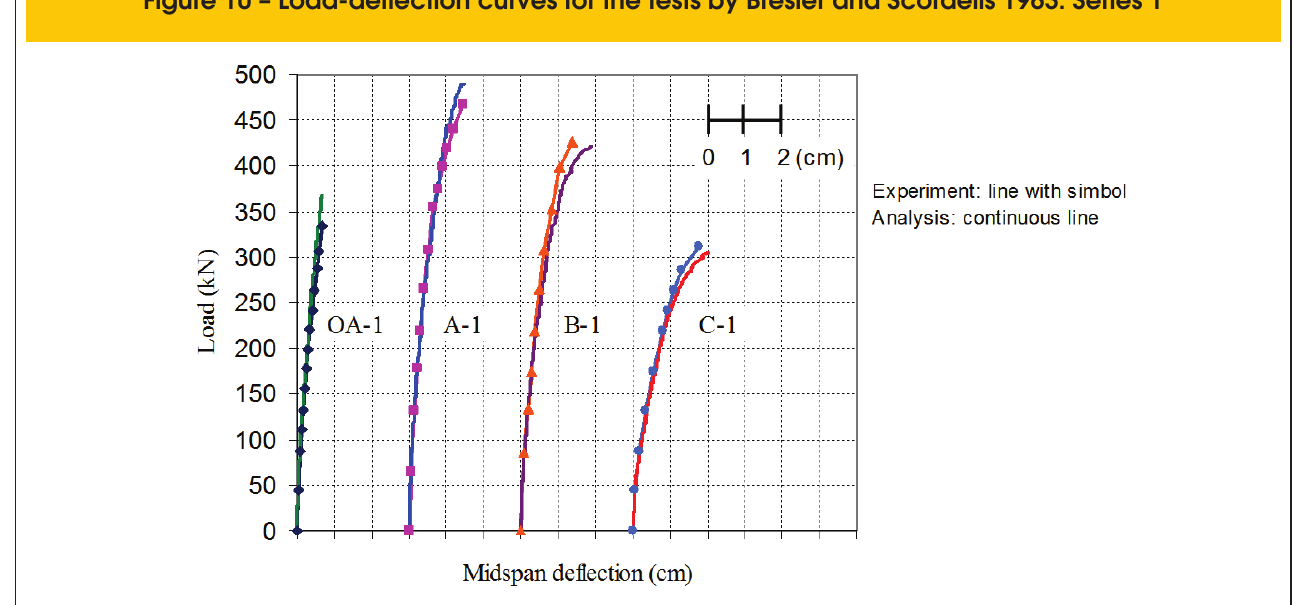
Figure 10 – Load-deflection curves for the tests by Bresler and Scordelis 1963: Series